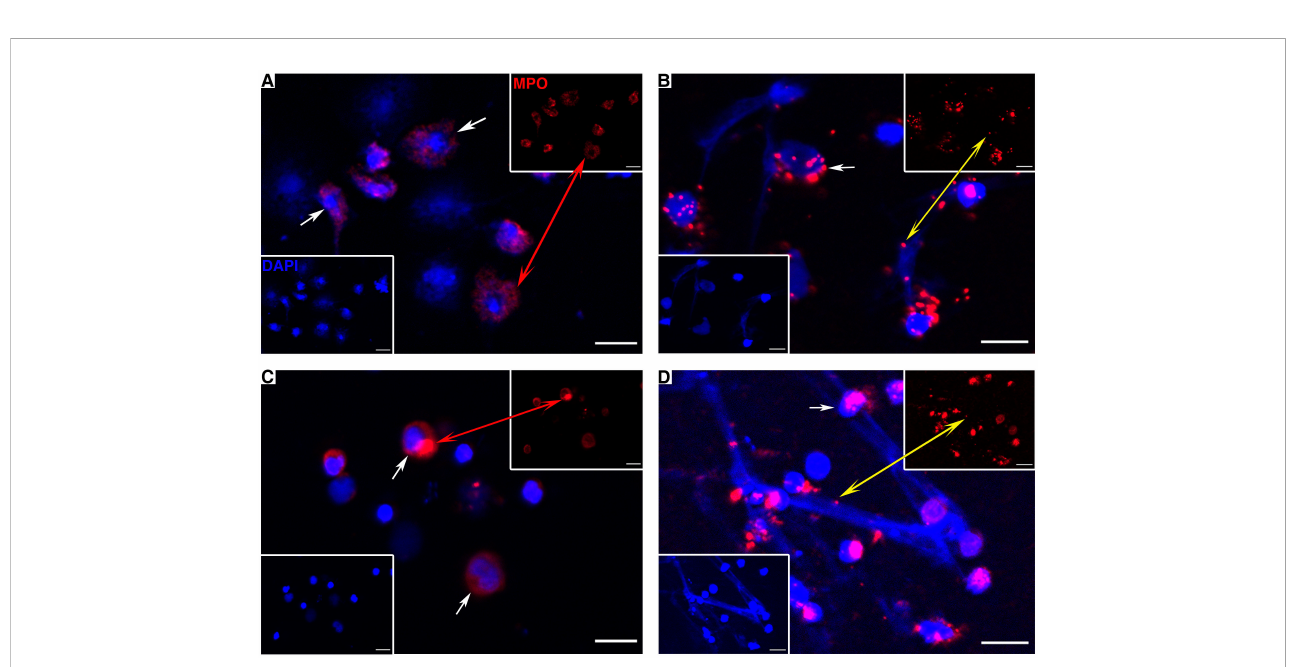
FIGURE 6 Po MPO positive cells (continuous arrows or red double arrow) and MPO protein on ETs (yellow double arrow) in peritoneal cells (A, B) and head kidney leukocytes (C, D) . (A, C) show the control cells without stimulation; (B, D) show PMA-induced ET formation. Blue indicates the nuclei and DNA fi bers stained by DAPI. Bar = 10